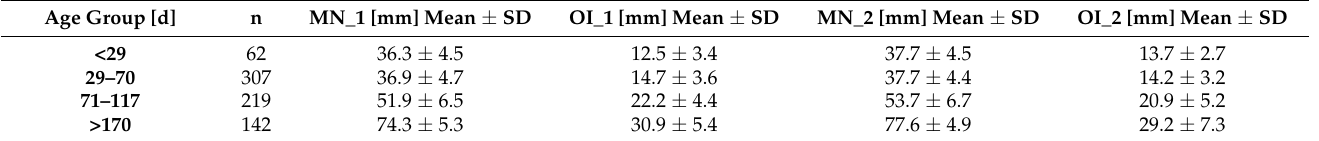
Table 3. Mean values including standard deviations for the optimum injection point (OI) and the length to the middle of the neck (MN) at first (_1) and second (_2) measurement point for each of the four defined age